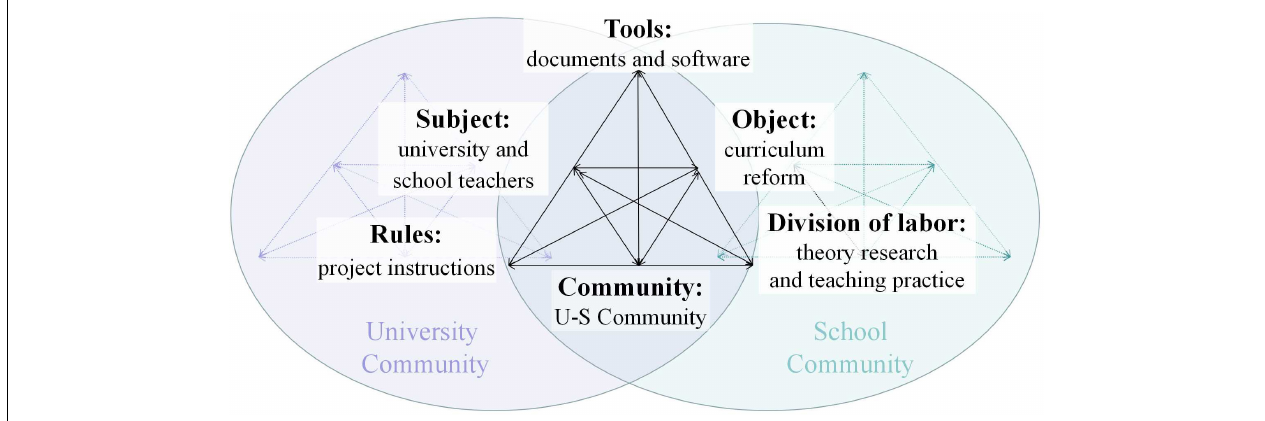
FIGURE 1 | The U-S community in the Chinese EFL curriculum reform. [Adapted with permission of Cambridge University Press through PLS Clear from He and Lin (2013)].